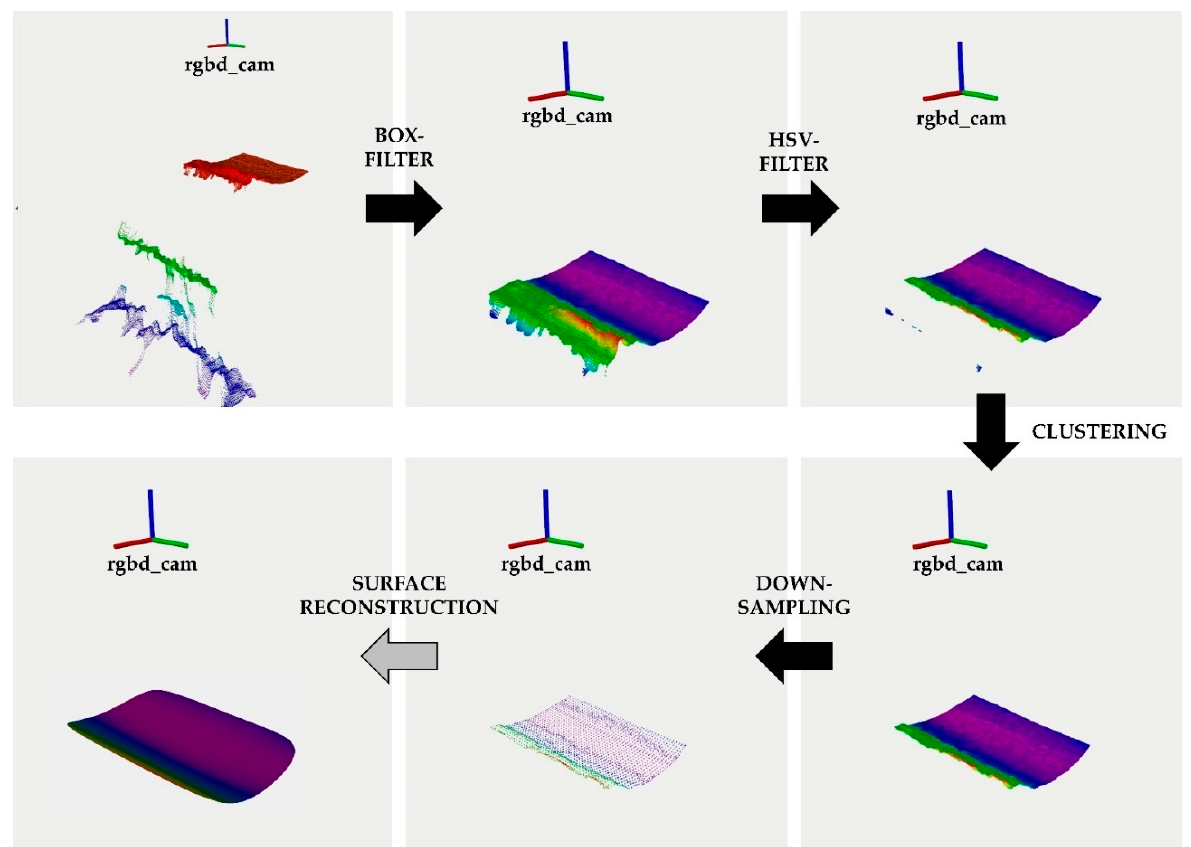
Figure 16. Processing pipeline of the surface reconstruction at a local workpiece subsegment.